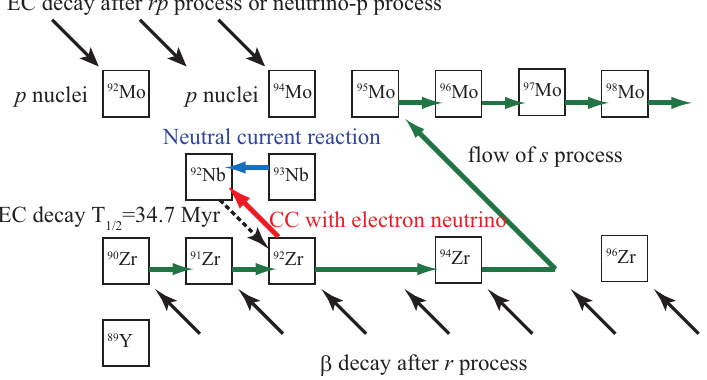
Figure 1. Nucleosynthesis flow and key nuclear reactions around 92 Nb